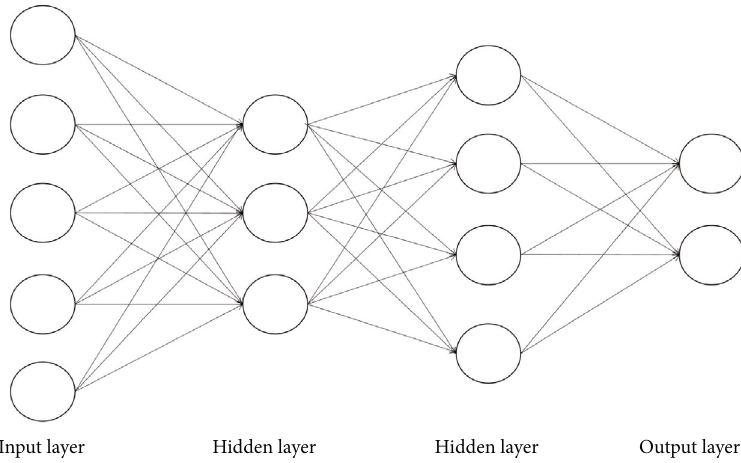
Figure 1: Arti fi cial neural network model for deep